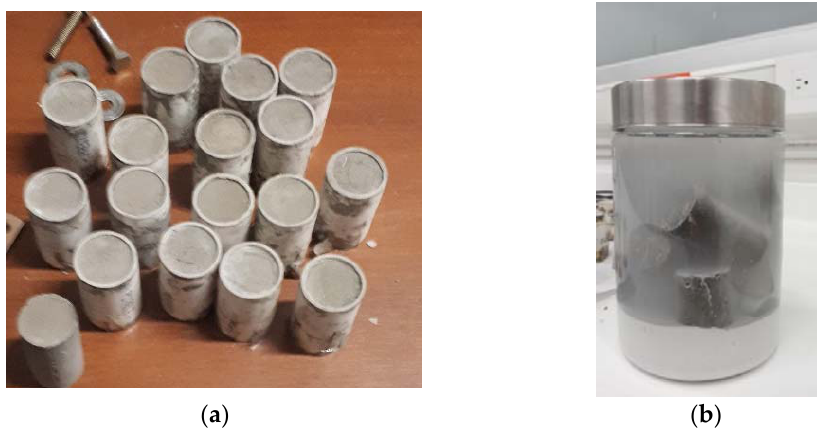
Figure 3. Image of the test cylinder ( a ) during the drying process and ( b ) during the curing and storage process.